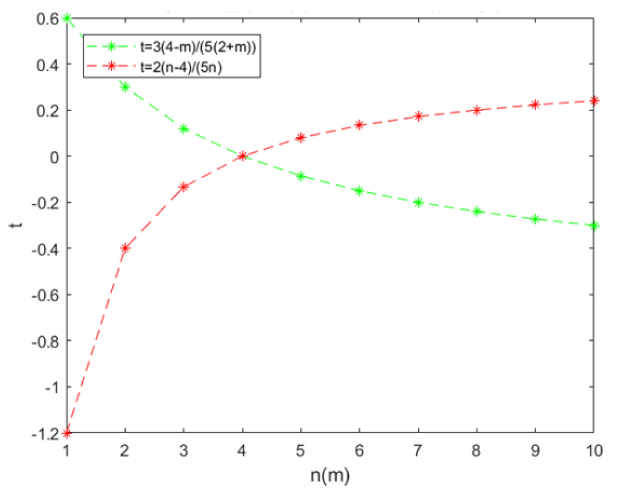
Figure 15. Relationship between the optimal strategy and degrees of concentration in upstream and downstream countries under a specific